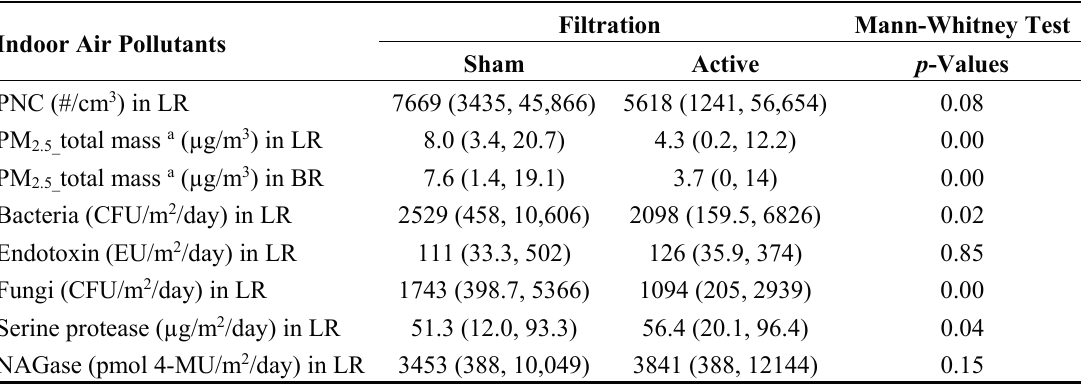
Table 2. Exposure levels of particles and settled dust bio-aerosols in the living or bedroom of the participants during sham and active indoor air